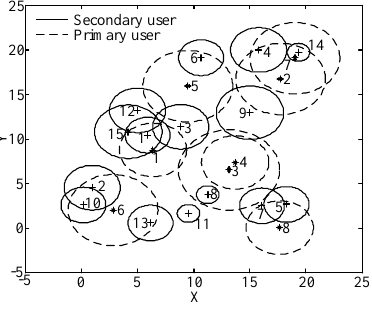
Figure 2 The distribution of interference